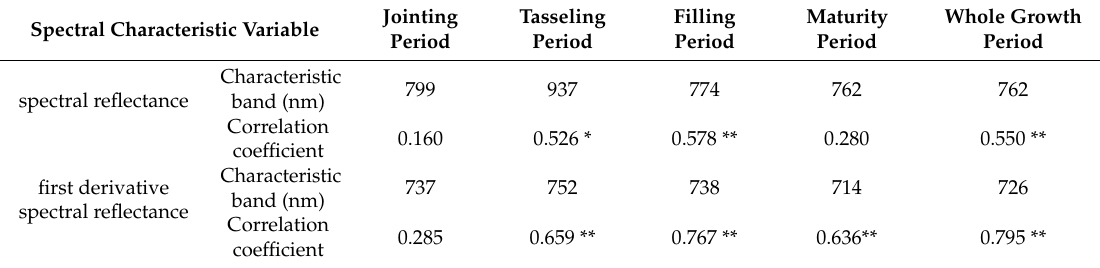
Figure 4. Correlation between canopy spectral reflectance and its first derivative and nitrogen concentration in summer corn. ( a ) the correlation coe ffi cient between the canopy spectral reflectance and canopy nitrogen concentration of summer corn; ( b ) the correlation coe ffi cient between the first derivative of the canopy spectral reflectance of summer corn and canopy nitrogen concentration. Table 2. Correlation coe ffi cients between summer corn canopy nitrogen concentration and spectral reflectance and its first